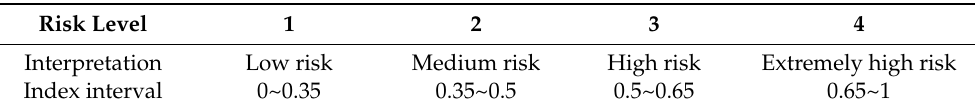
Table 7. Risk classification